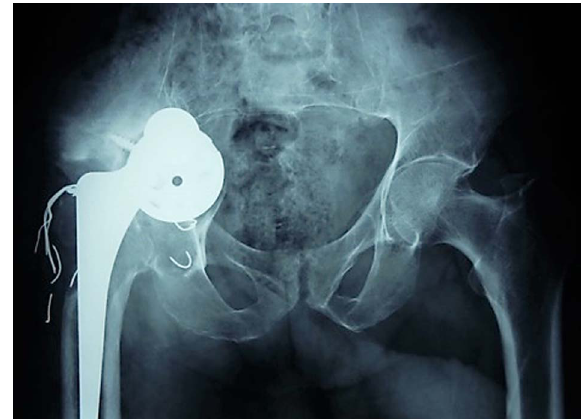
Figure 1. Anteroposterior X-ray of the pelvis showing acetabular component migration medial to Kohler's line with proximal migra- tion of the stem.